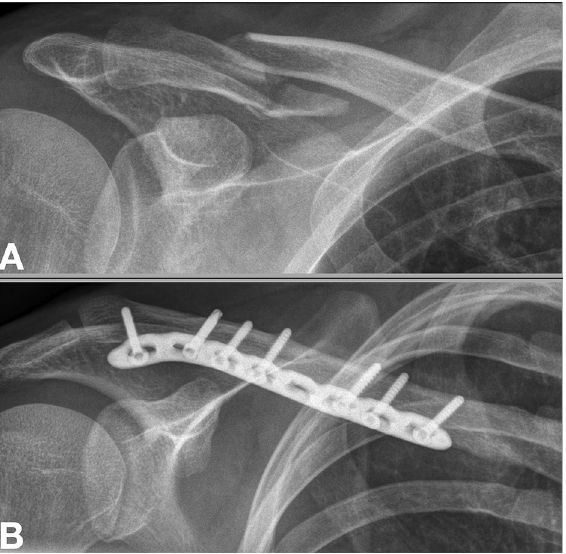
Figure 2. Radiographic anteroposterior images (right shoulder) of an 18-year-old male following a fall while playing soccer demonstrating a midshaft clavicle fracture and fracture fixation with an anteroinferior plate. ( A ) Displaced midshaft clavicle fracture, ( B ) plate fixation with an anteroinferior